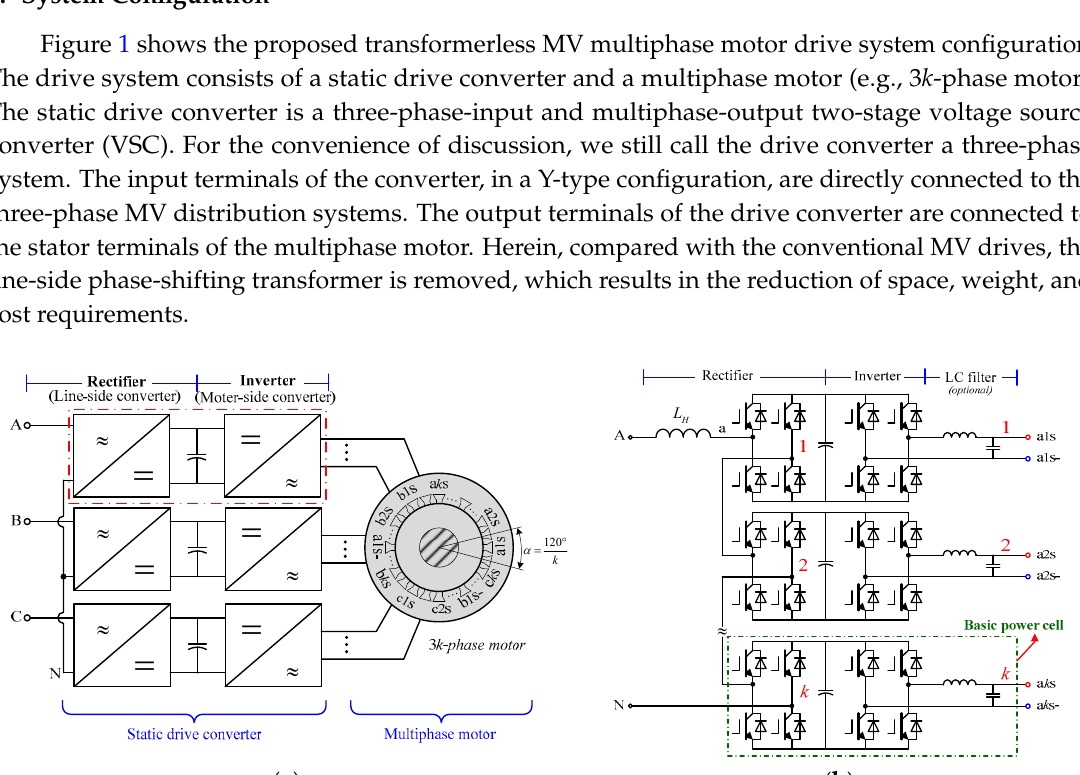
the power source (e.g., MV distribution systems), and the k back ‐ end H ‐ bridges form k independent